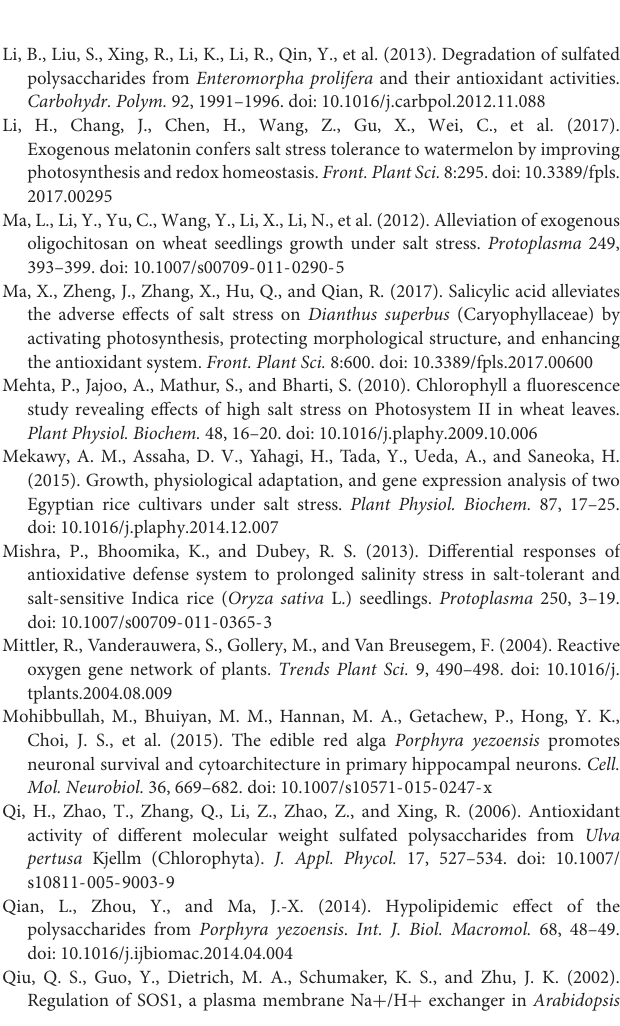
TABLE S1 | Reaction conditions of degraded polysaccharides from P. yezoensis . TABLE S2 | Primers used for quantitative real-time